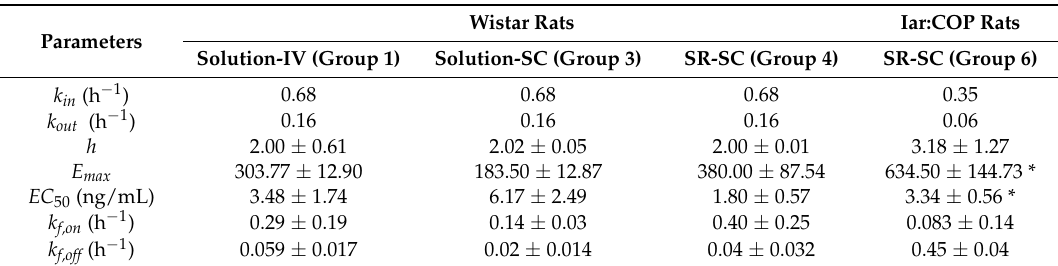
Table 4. The estimated parameters used to predict the pharmacodynamics of leuprolide using the developed PK–PD model (mean ± SE, n =